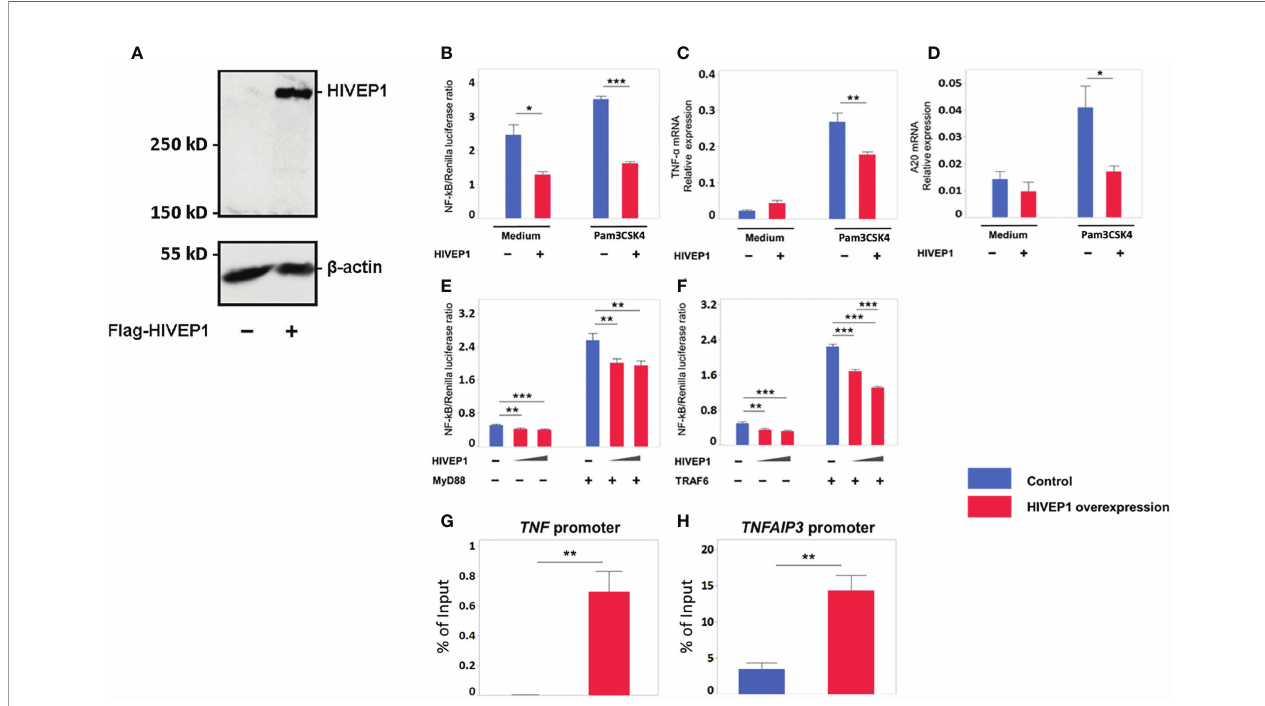
FIGURE 2 | Overexpression of HIVEP1 inhibits NF- k B activity upon Toll-like receptor stimulation and binds to the TNF and TNFAIP3 promoter regions. (A) HIVEP1 protein expression in HEK293T cells transfected with HIVEP1 expression vector (1 µg) or control plasmid (B – D) CD14/TLR2 HEK293T cells were transfected with 83 ng of HIVEP1 or control vector together with 33 ng of NF-kB and 0.7 ng of Renilla constructs and incubated with medium or PAM3CSK4 (1 µg/mL); overexpression of HIVEP1 was associated with reduced activity of NF- k B (B) , and reduced expression of TNF- a mRNA (C) and A20 mRNA (D) . HEK293T cells transfected with MyD88 (E) or TRAF6 (F) (or control cells) were co-transfected with increasing doses of HIVEP1 expression vector (0, 30 or 150ng); these MyD88 or TRAF6 transfected cells were not stimulated with PAM3CSK4; overexpression of HIVEP1 was associated with a dose-dependent inhibition of MyD88 or TRAF6 driven NF- k B activity. mRNA expression was normalized to HPRT mRNA. Data shows means ± SEM. (G, H) HEK293T cells were transfected with 30 µg of HIVEP1 expression vector or control plasmid. 24 hours after transfection, the cells were collected for CHIP analysis. RT-qPCR ampli fi cation was performed with total DNA and immunoprecipitated DNA using TNF and TNFAIP3 promoter primers spanning the NF- k B binding regions. Data shows means ± SEM and presented as a percentage of input DNA. Data shown were pooled from two (A,B,C) , three (E, F) independent data sets (four replicates samples for each condition within each experiment) and three (G, H) independent data sets (two duplicate samples for each experiment)*P < 0.05, **P < 0.01, ***P <